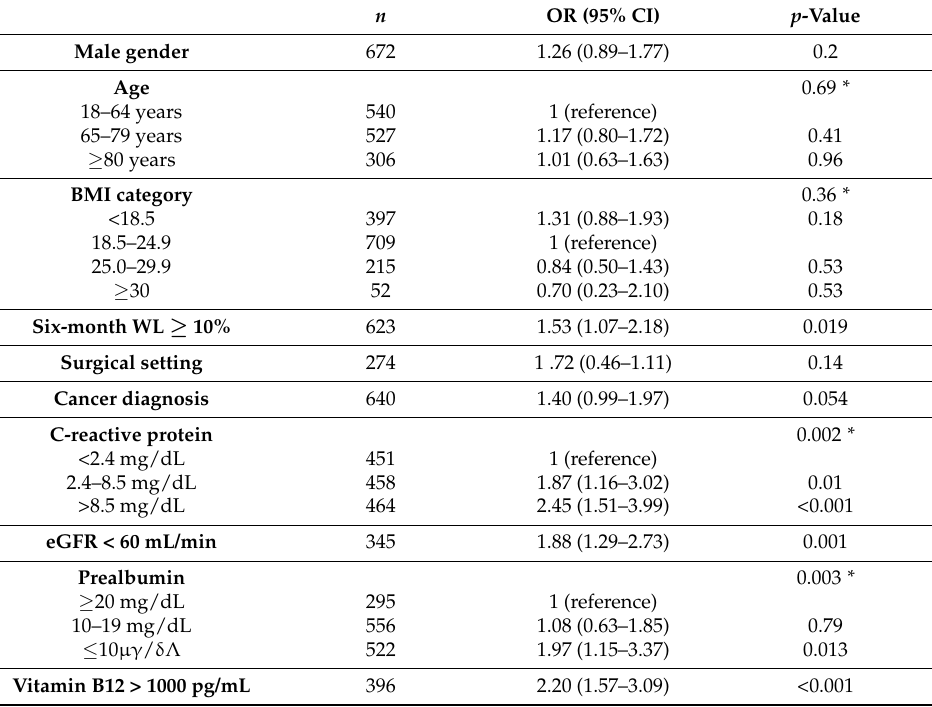
Table 3. Multivariate logistic regression of predictors of in-hospital